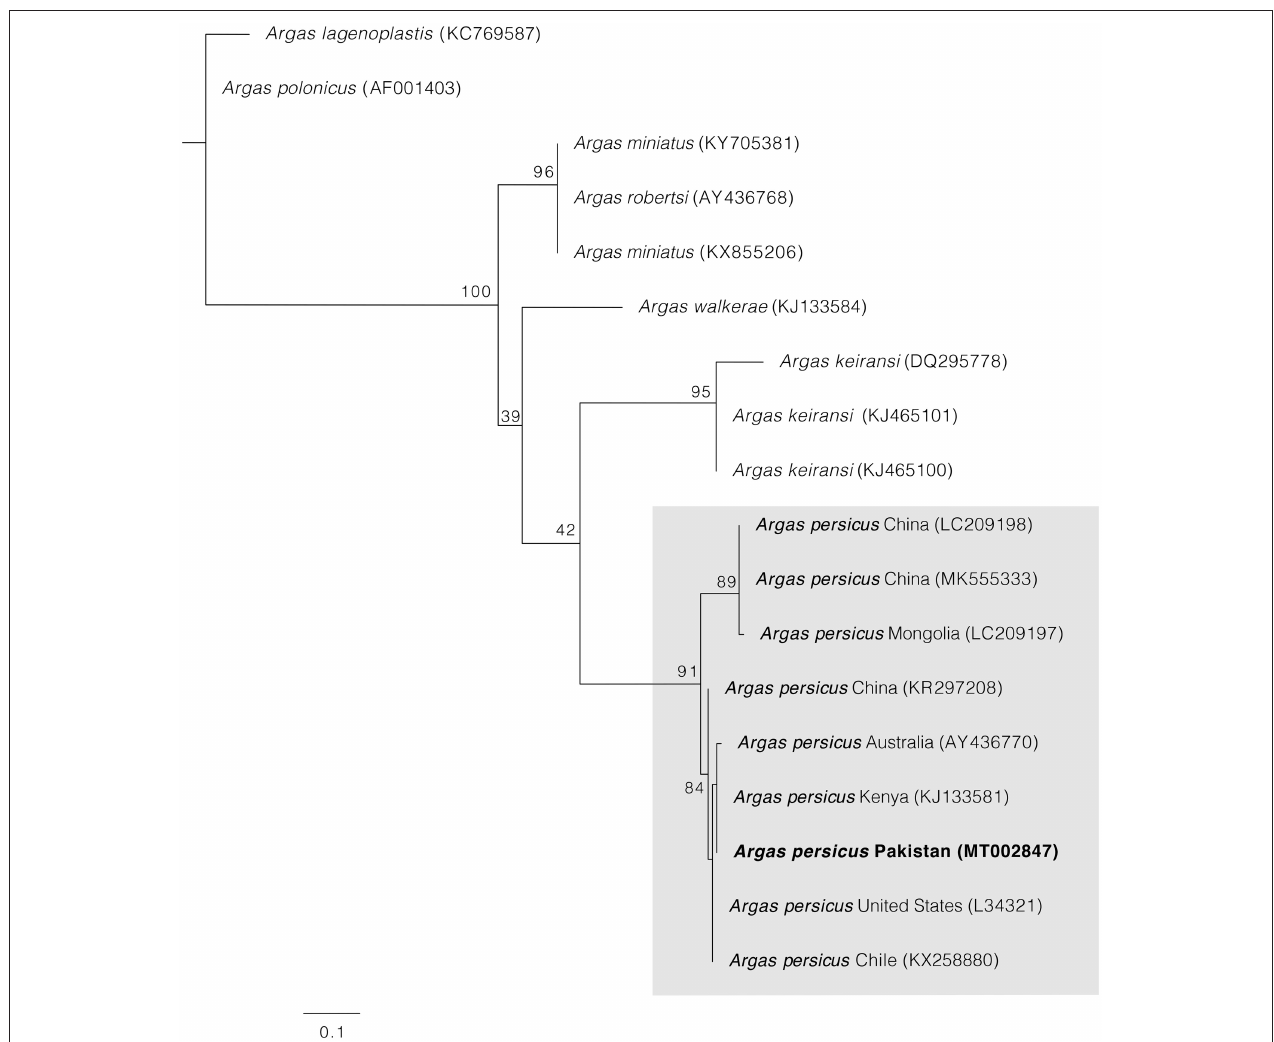
FIGURE 5 | Maximum likelihood tree constructed for the 16S sequence of A. persicus generate in this study. Species names are followed by country and accession numbers in parentheses. Bootstrapping values (1,000) are shown at each node. The bar represents 0.1 substitutions per site. Sequence obtained in the present study is highlighted in